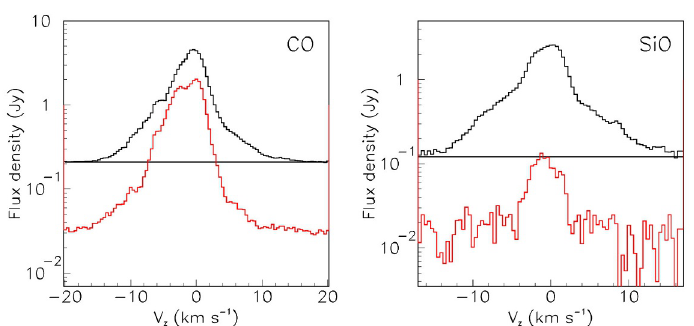
Figure 9: Mira Ceti: Doppler velocity distributions of CO (left) and SiO (right) line emission within a circle of 0.25 arcsec projected radius centred on the main star Mira A (black, upper) or its companion Mira B (red, lower).